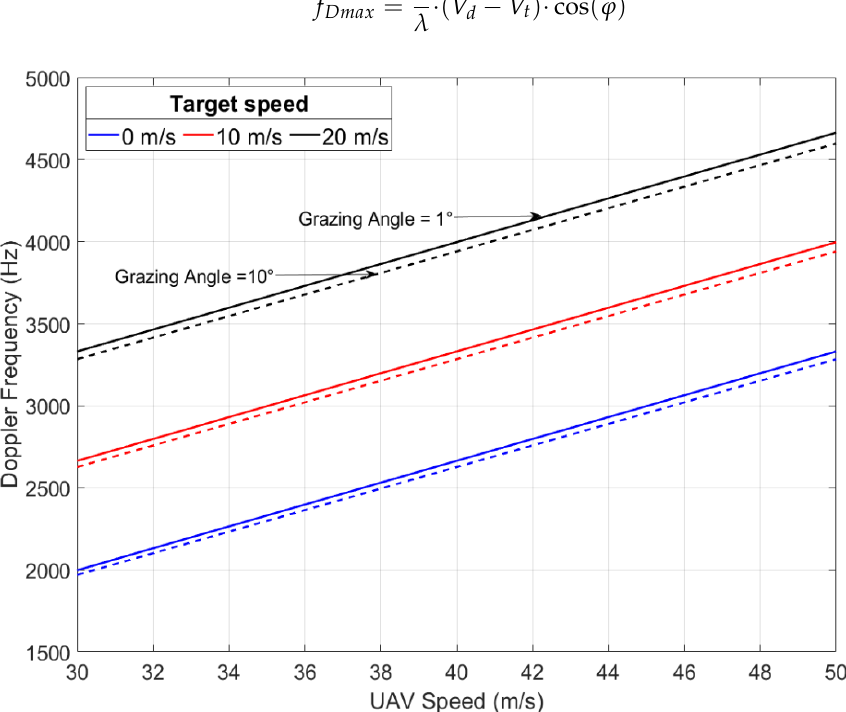
Figure 16. Doppler frequency at θ = 0 versus UAV speed and target speed.